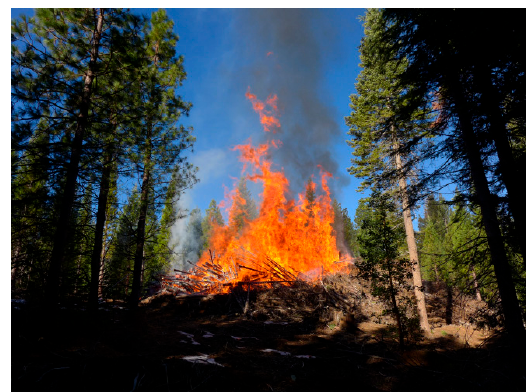
Figure 1. Open pile burning.